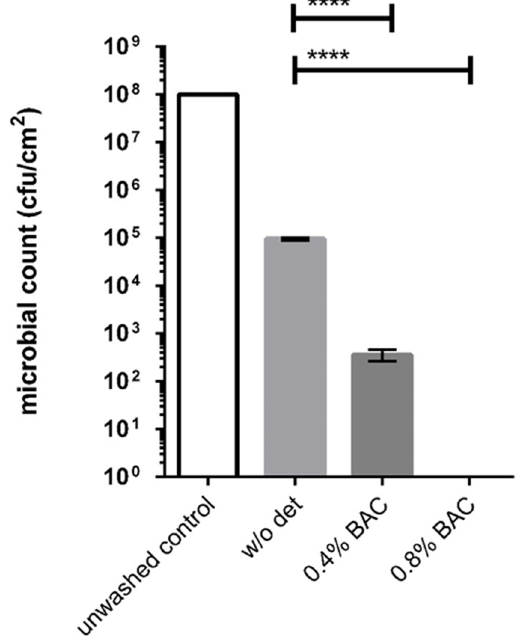
Figure 5. Microbial counts of MlShCj models after a simulated wash cycle (Rotawash) without detergent (w/o det), with 0.4% benzalkonium chloride (BAC) (0.4% BAC), and with 0.8% BAC (0.8% BAC), followed by a 7 day incubation period as described for the malodour model in general. An unwashed sample served as the control, ****: p < 0.0001.